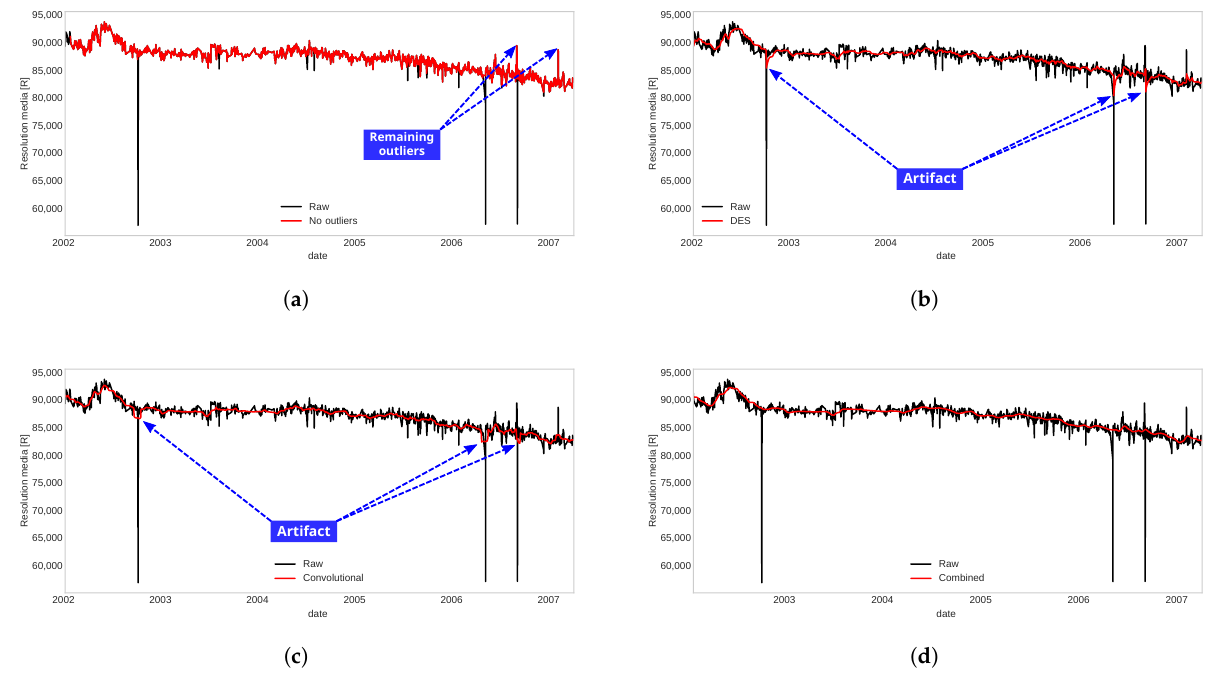
Figure 2. Application of each method separately to the raw signal. ( a ) Outliers and spikes cleaning. ( b ) Double Exponential Smoothing. ( c ) Convolutional smoothing. ( d ) Proposed pre- processing